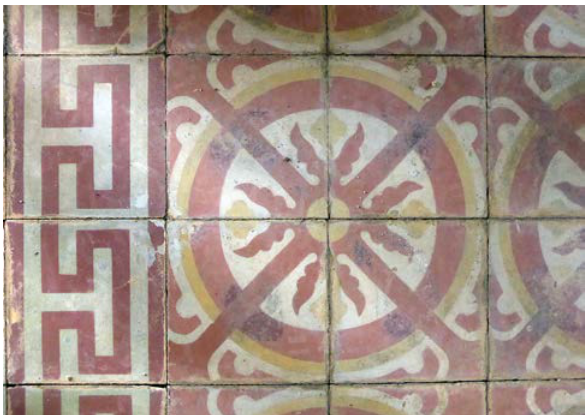
Figure 15. The types of floor and elements in reinforced concrete